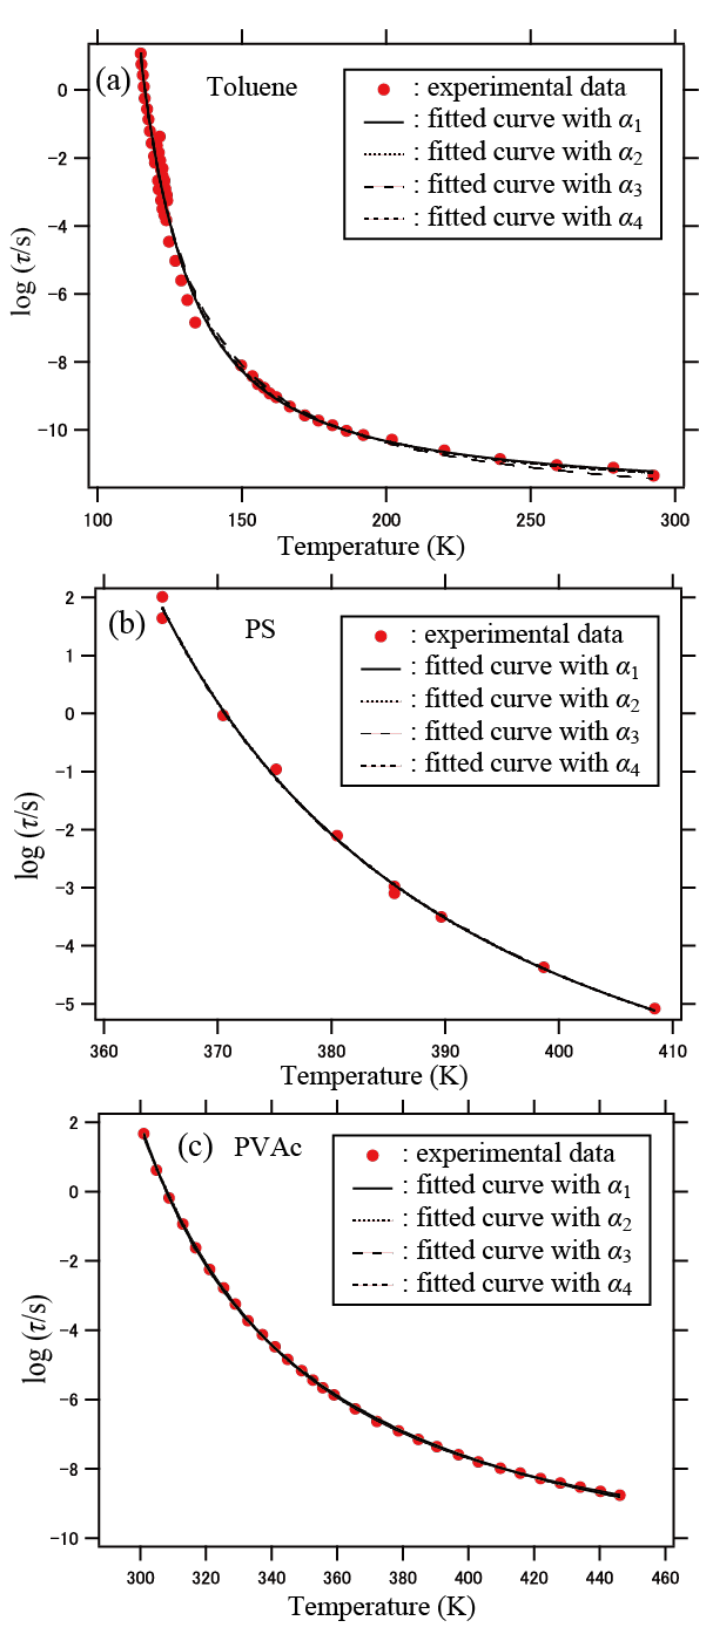
Figure 6. Relaxation time with respect to temperature for ( a ) toluene, ( b ) PS, and ( c ) PVAc. The solid curves are the results of least squares fitting analyses with Equation (7) for α 1 , α 2 , α 3 , and α 4 . The experimental data were reproduced from the literature as shown in the text.